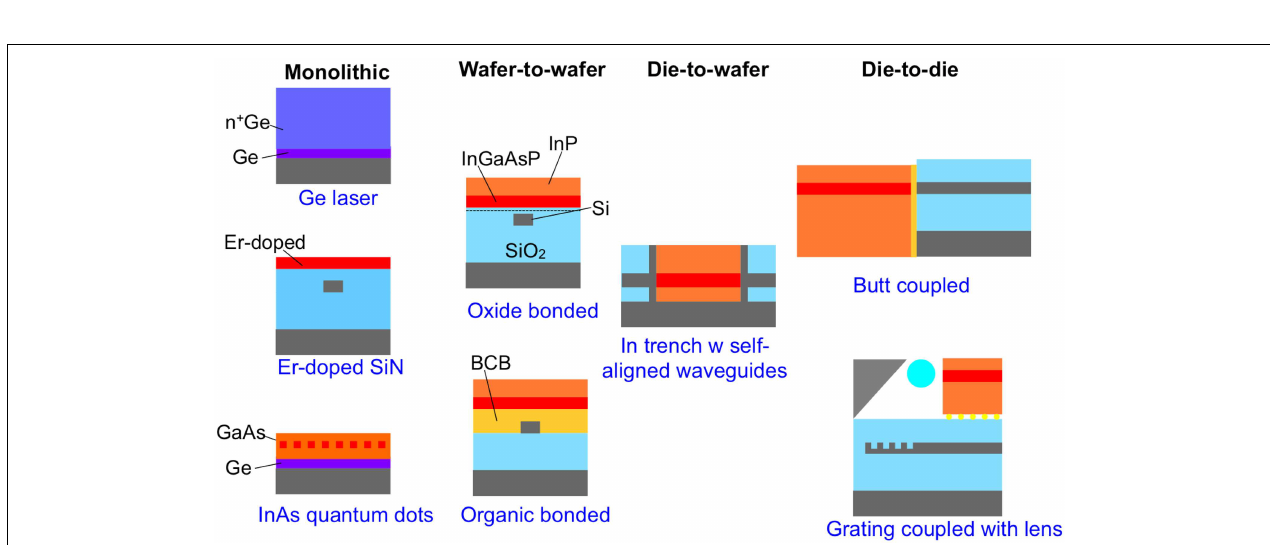
FIGURE 10 | (A) Cross sections of various silicon-based optical modulator designs and (B) photodetector designs.